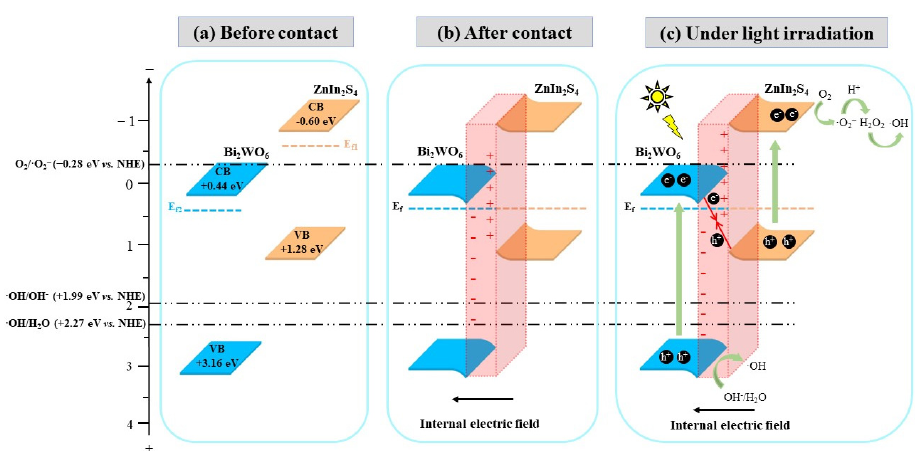
Figure 8. Proposed mechanism for the enhancement of photocatalytic performance of ZnIn 2 S 4 /Bi 2 WO 6 heterostructured photocatalyst: ( a ) The band structure of the single component pho- tocatalyst before contact; ( b ) The band structure of ZnIn 2 S 4 /Bi 2 WO 6 heterostructured photocatalyst after contact in hydrothermal reaction; ( c ) The charge carriers transfer pathway of ZnIn 2 S 4 /Bi 2 WO 6 heterostructured photocatalyst under light